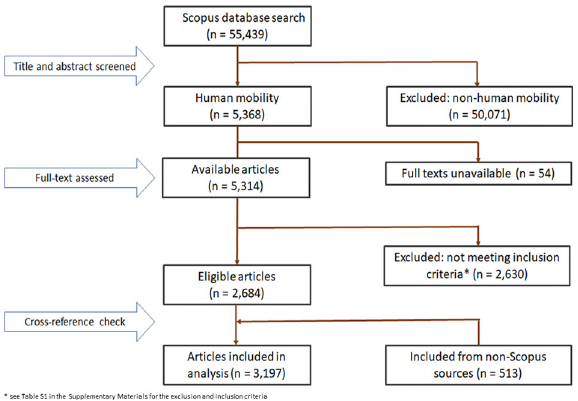
Fig. 1 Flowchart of the systematic literature search. n is the number